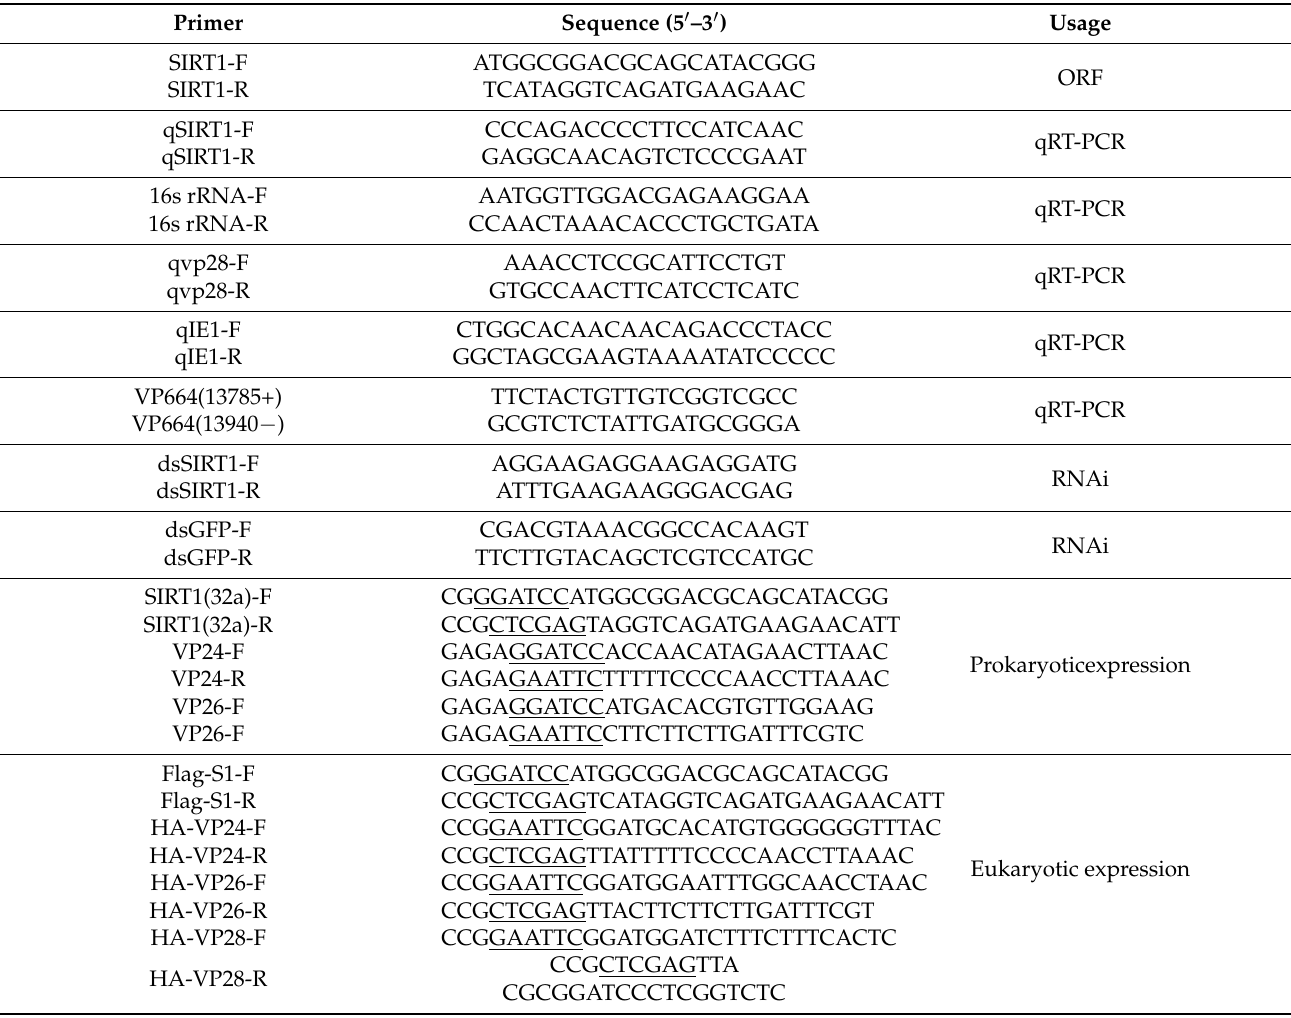
Table 1. Primer sequences used in this